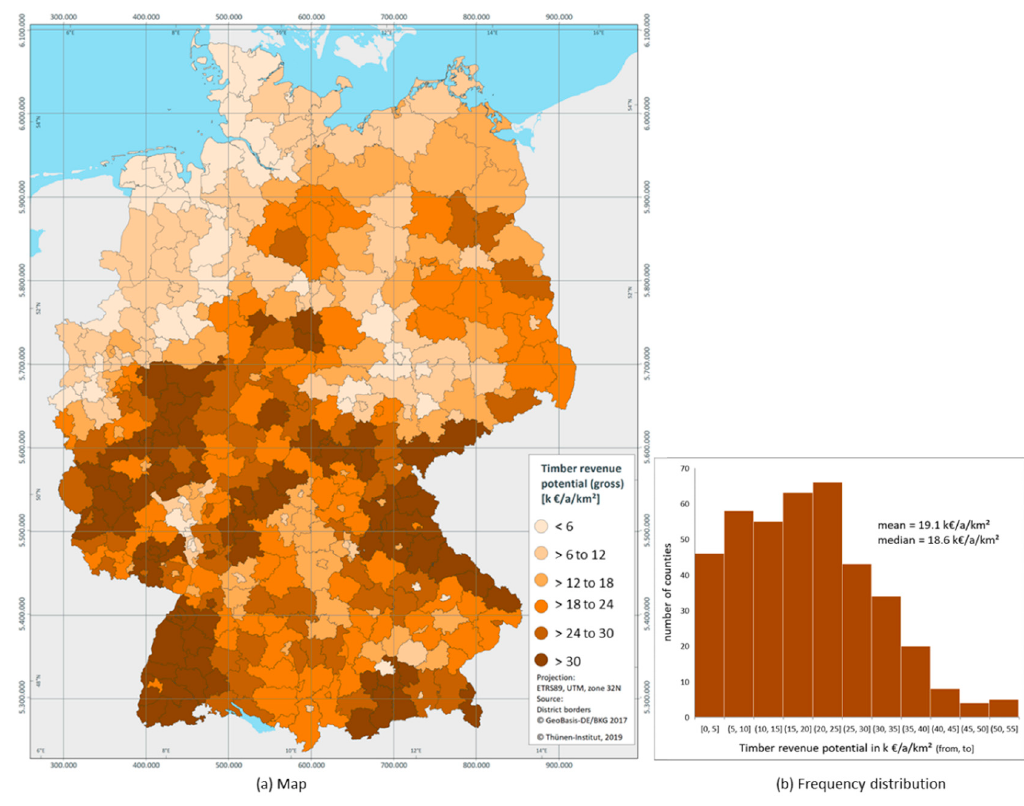
Figure 5. Annual benefits of timber production in Germany: gross revenue potential in the counties.